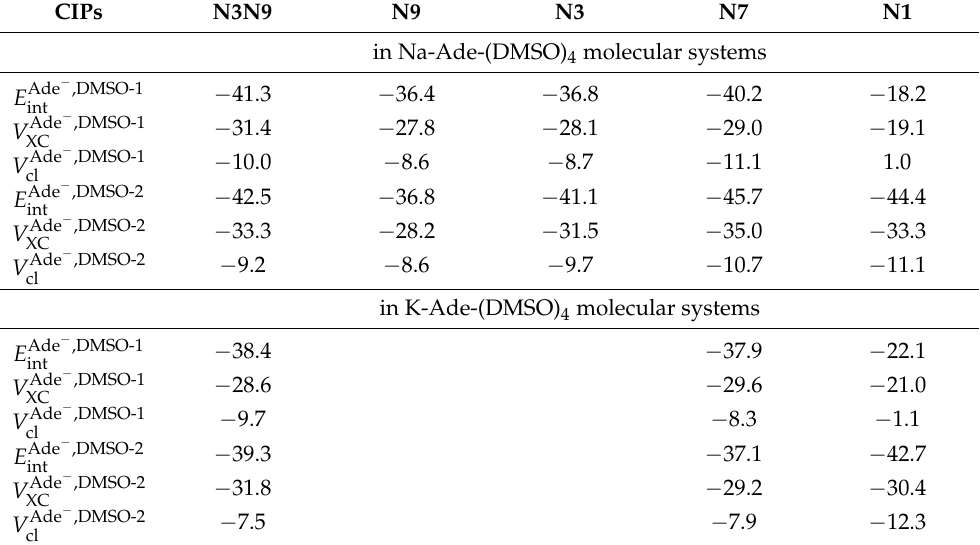
Table 7. The total interaction energy, E Ade − ,DMSO V Ade , components computed for DMSO-1 and DMSO-2 solvent molecules in the indicated cl M-Ade-(DMSO) 4 molecular systems. All values in kcal mol − 1